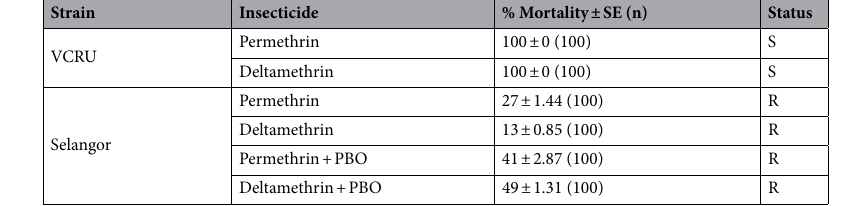
Table 2. Resistance status of Aedes aegypti female adults after 24 h exposure period towards two different types of WHO insecticide treatments (permethrin 0.75% and deltamethrin 0.05%) and PBO synergist for susceptible VCRU lab strain and Selangor field strain. S indicated susceptible and R indicated